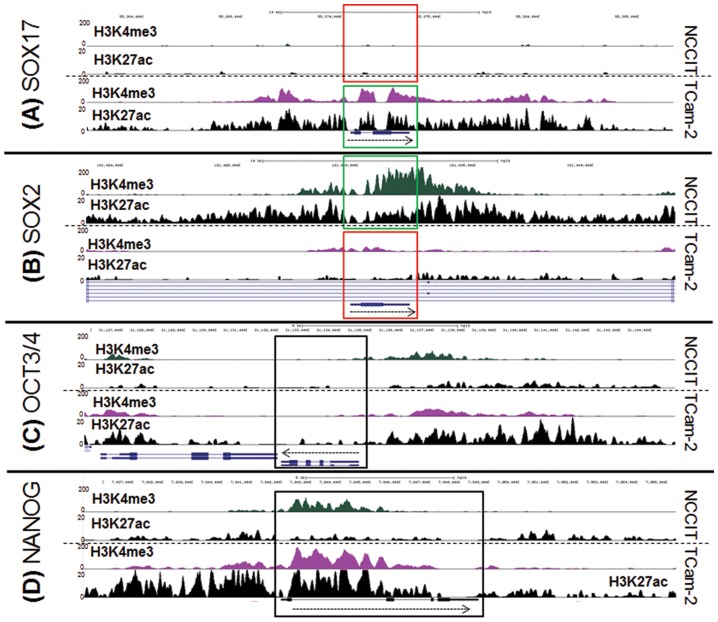
Display of H3K4me3 and H3K27ac tracks for both NCCIT and TCam-2. (A) SOX17, (B) SOX2, (C) OCT3/4 (POU5F1), (D) NANOG.Arrows indicate direction of transcription. Green boxes indicate markers specific for the histological subtype represented by the cell line. Black boxes  =  no difference between the cell lines; red boxes  =  not a marker for that cell type. Note the different ranges on the y-axis for H3K4me3 and H3K27ac.